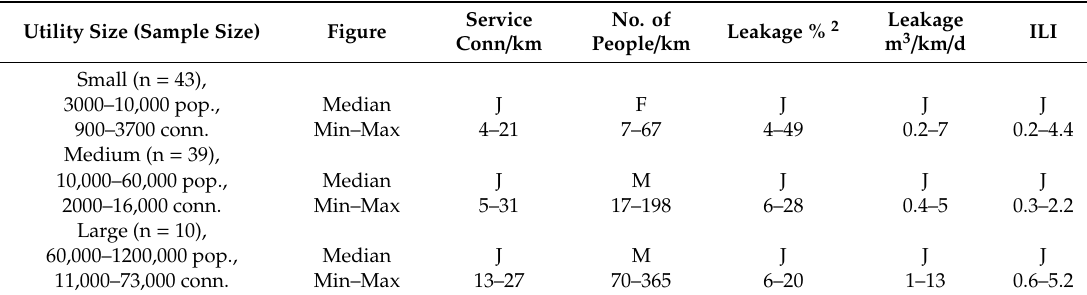
Table 3. Median, minimum and maximum values for key leakage level characteristics for the 92 Finnish water utilities grouped by size, and the share of utilities with leakage reduction potential in the size groups in 2015–2017. 1 ILI: Infrastructure Leakage Index.